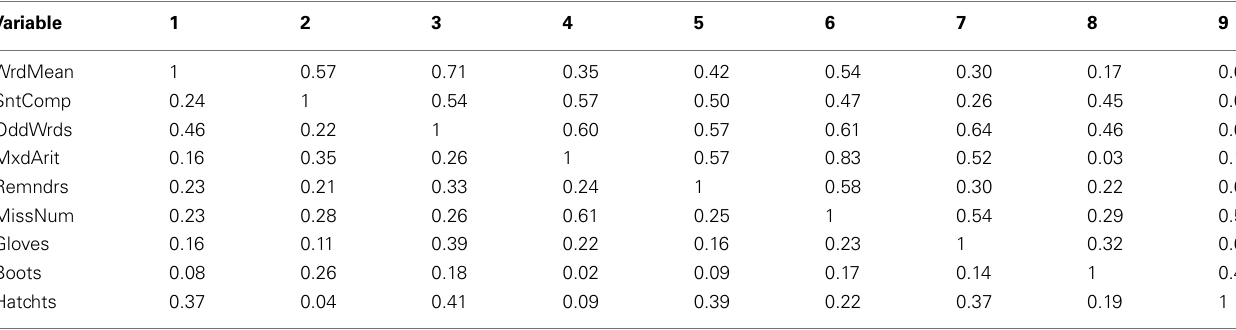
Table 9 | Product-moment and polychoric correlations among Case 3 item-level